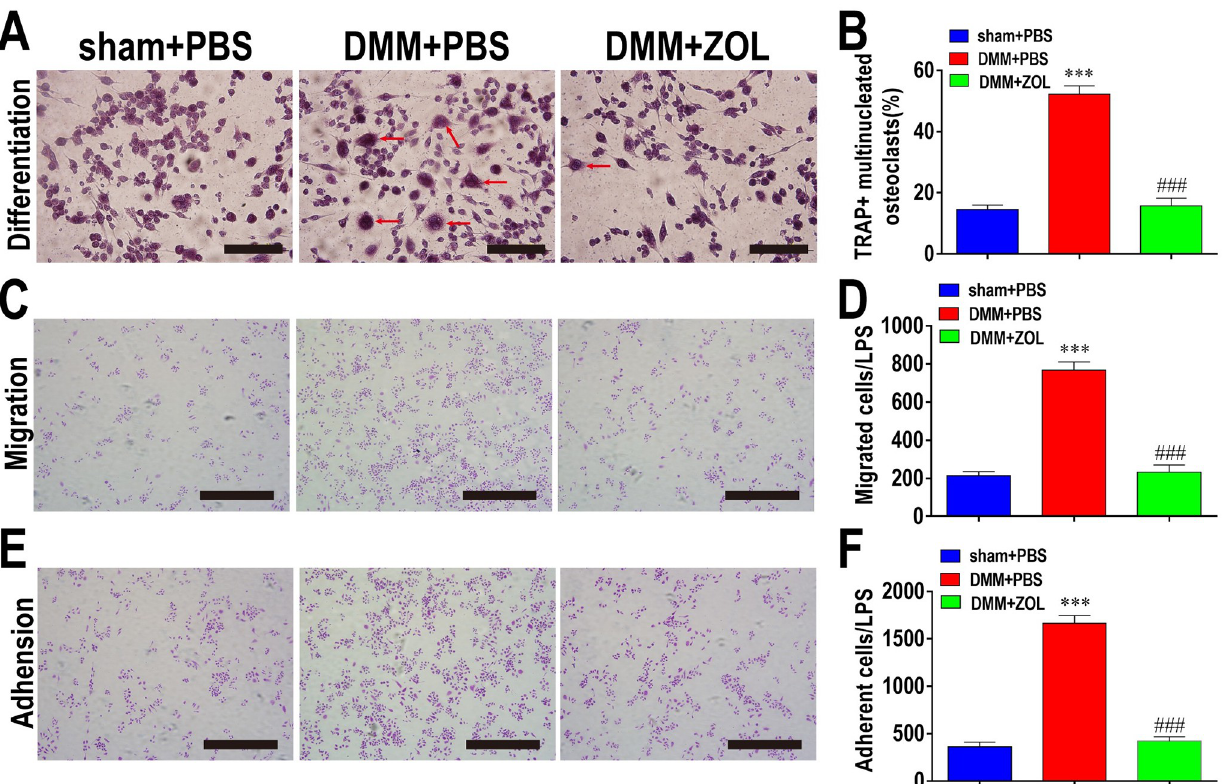
Fig 6. ZOL attenuates BMM activity in vitro 4 weeks after DMM-induced OA. (A) Ability of BMMs to differentiate into multinucleated osteoclasts and (D) quantitative analysis of TRAP staining. Scale bar, 200 μ m. (B) Migrated and (C) adherent BMMs stained with crystal violet. Scale bar, 500 μ m. Quantitation of BMM (E) migration and (F) adhesion (n = 6 per group). ��� P < 0.001, compared with sham+PBS group; ### P < 0.001, compared with DMM+PBS group.